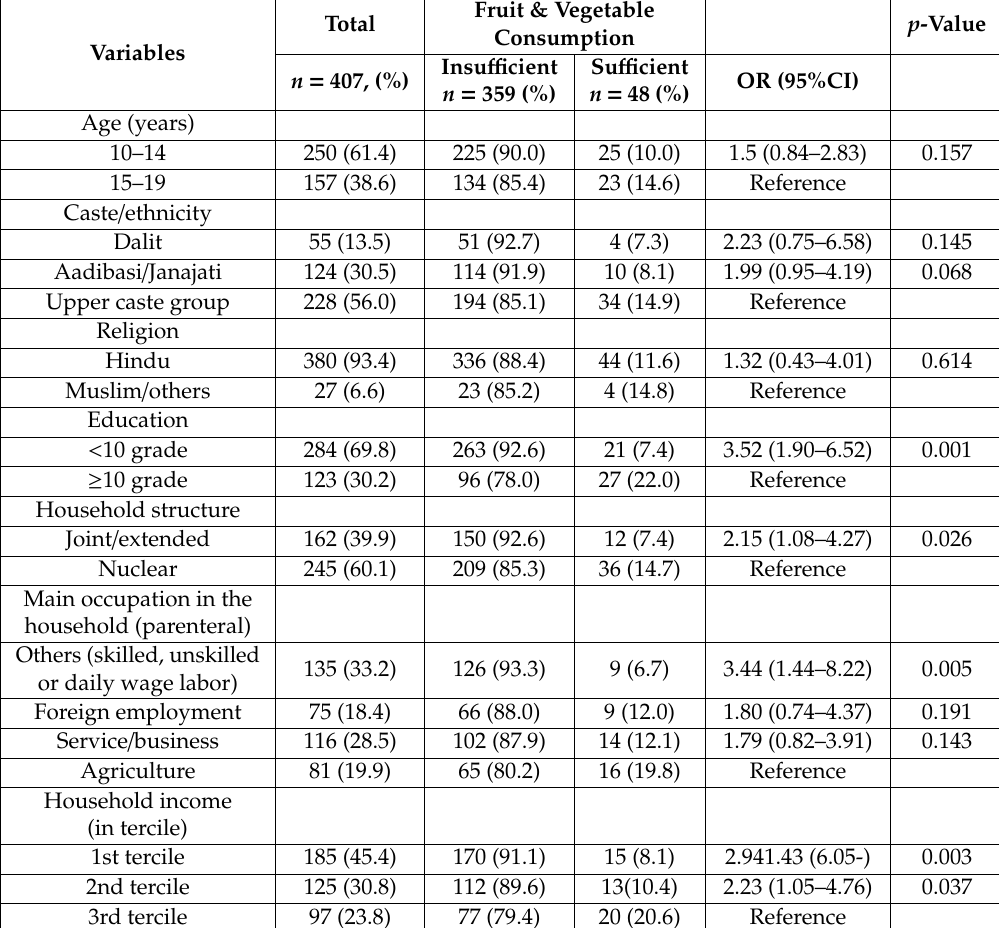
Table 1. Socio-demographic factors associated with fruit and vegetable consumption among adolescent girls in rural communities in the Dhanusha district of Nepal, 2018. Fruit & Total